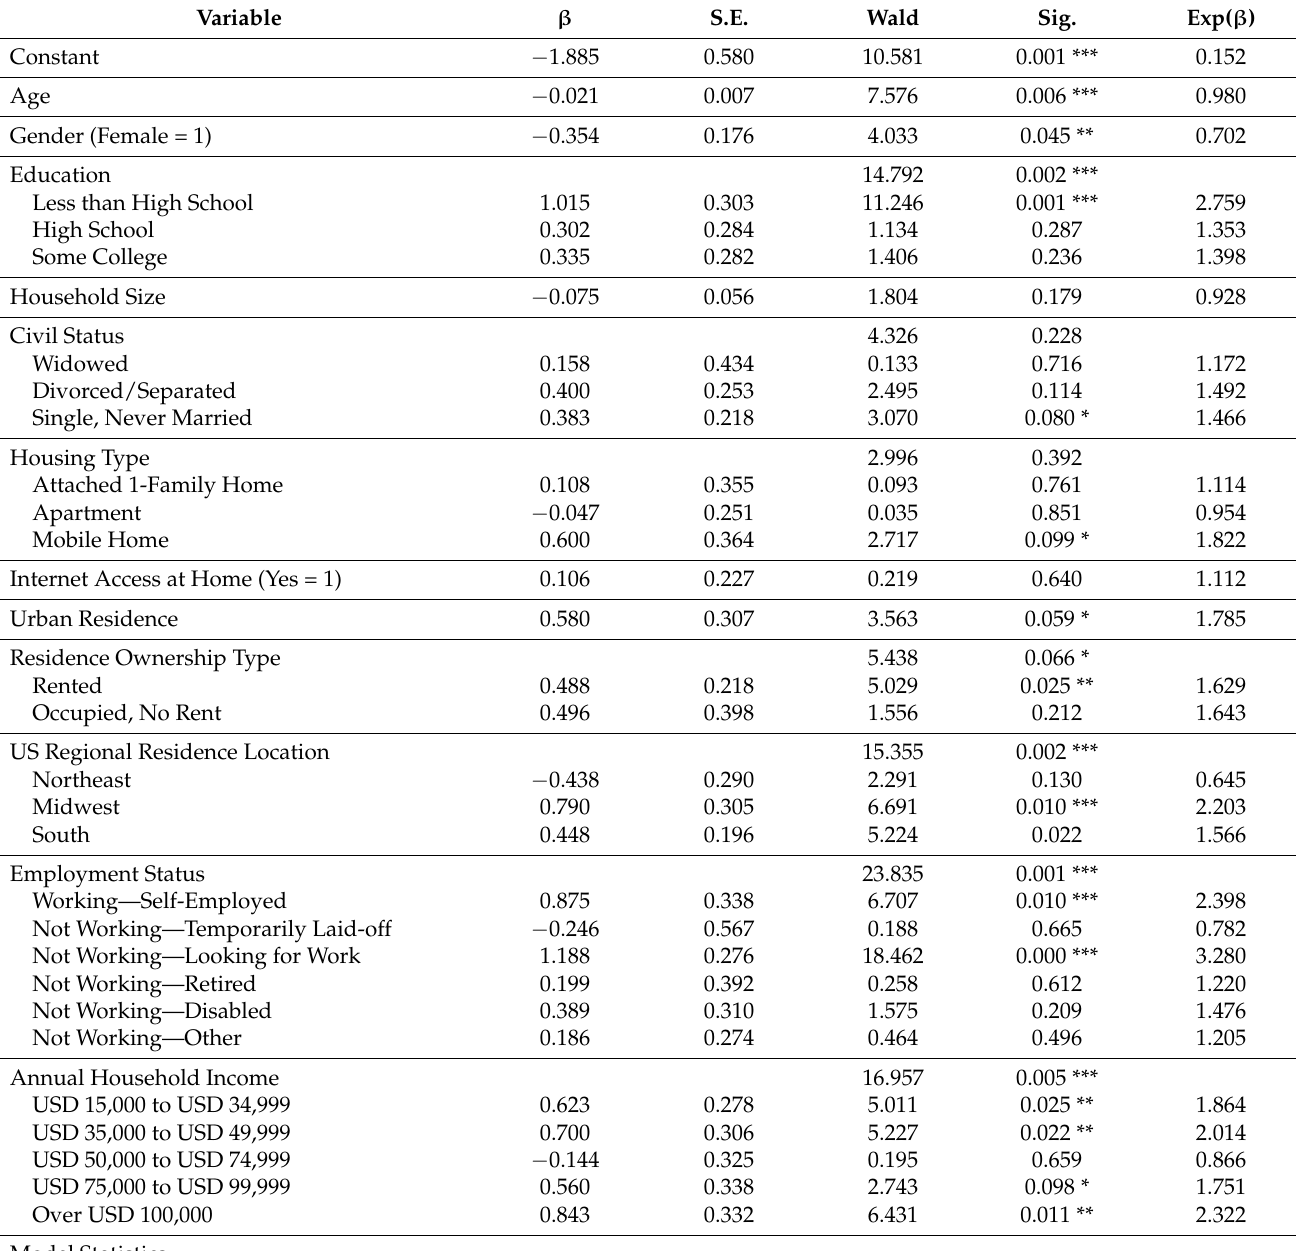
Classification Table (Hit Ratio) Percentage Correct: No = 96.5; Yes = 19.7; Overall = 79.7 Reference categories: Gender = Female; Education = BA/BS or Higher; Civil Status = Married/Living with Partner; Housing Type = Detached 1-Family House (boat, van, omitted); Internet Access at Home = Yes; Urban Residence = Urban; Residence Own- ership = Owned/Purchasing; US Residence Location = West; Employment Status = Working Wage and Salaried; Annual Household Income = Under USD 15,000. Note: ***, **, * signify statistical significance at the 0.01, 0.05, and 0.10